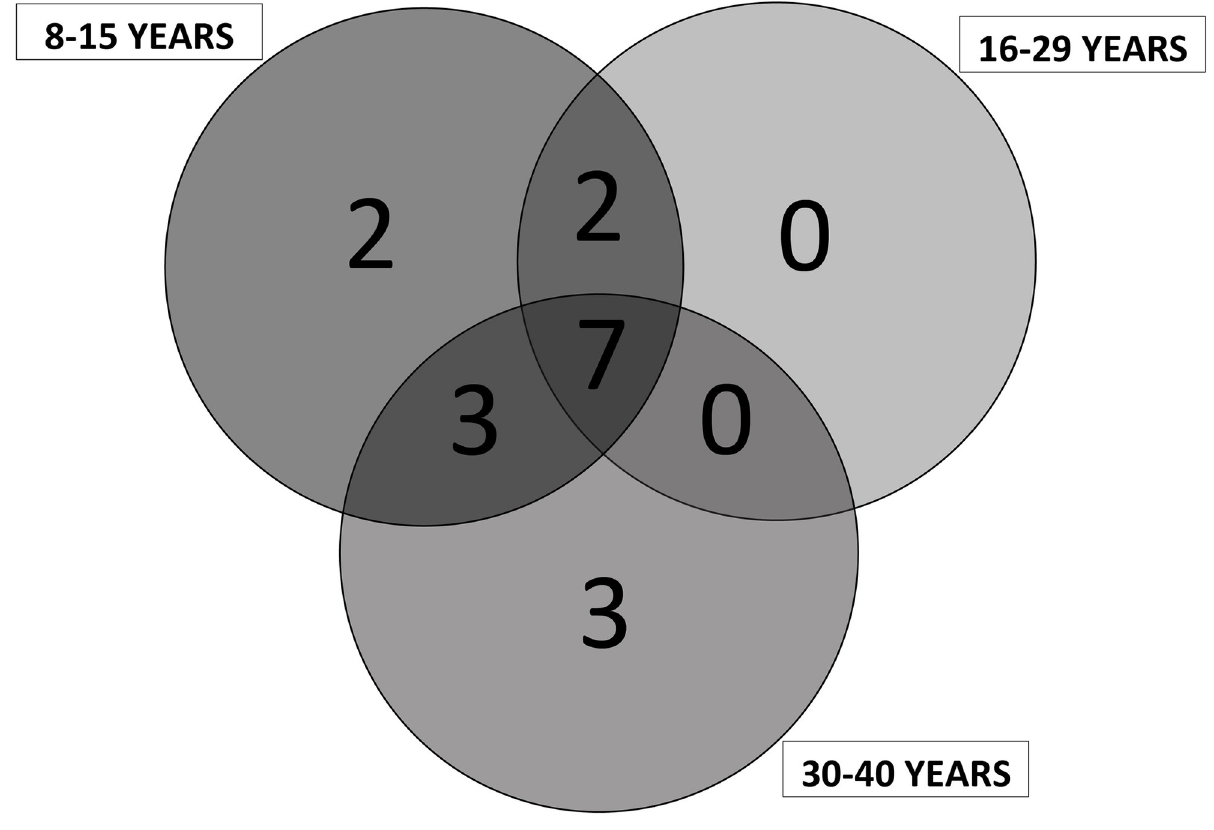
Fig 3. Number of species per age level of cocoa AFS.